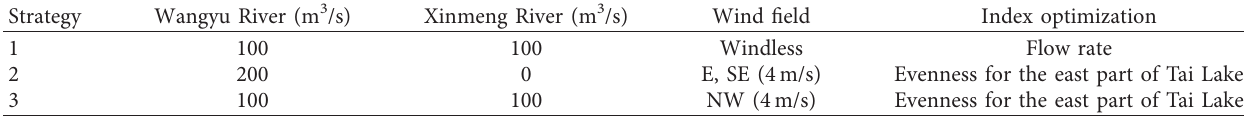
Table 4: Three optimal water diversion